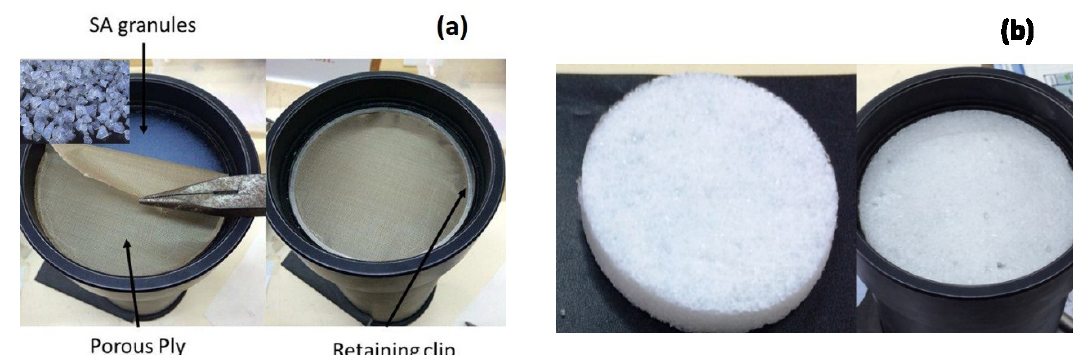
Figure 8. ( a ) Filling of SA granules in impedance tube; ( b ) GSA–SDS specimen.